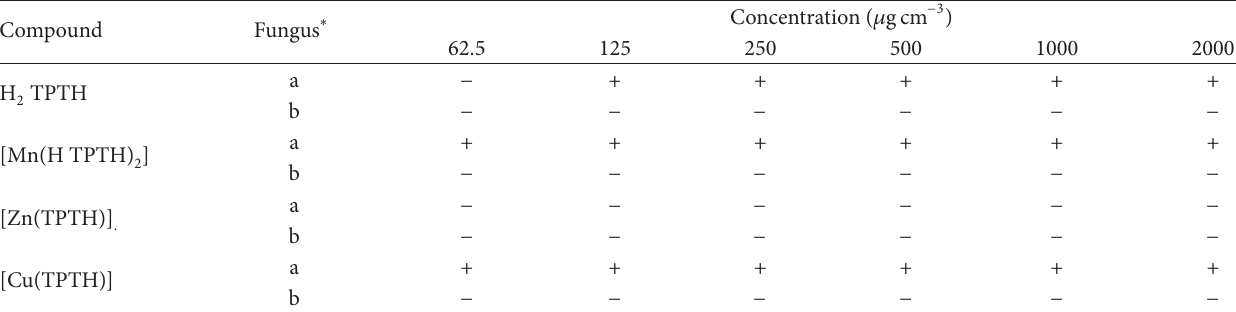
T 7: Antifungal activity of H